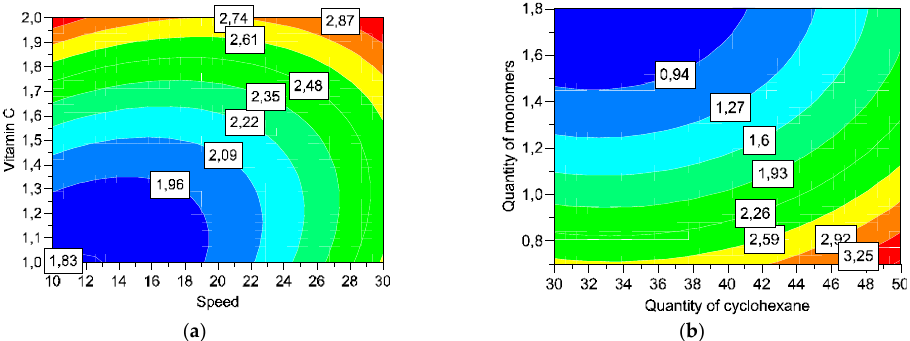
Figure 9. Response surfaces for release of vitamin C. by varying speed and vitamin C ( a ) and quantities of cyclohexane and monomers ( b ).